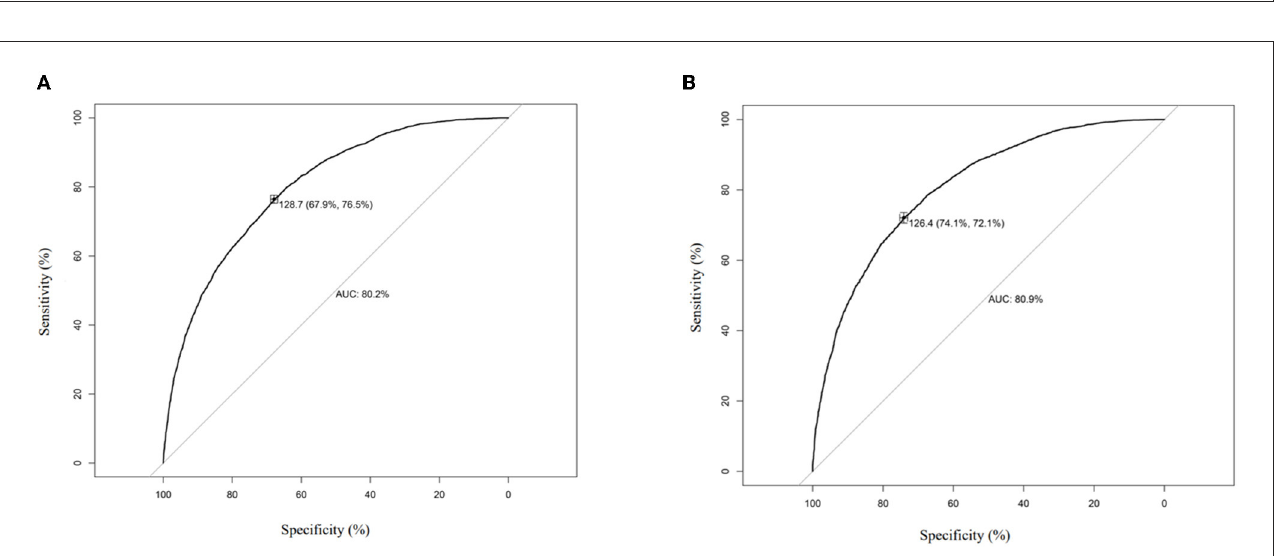
FIGURE4 ROC analysis of the nomogram. (A) In training set, (B) in validation set.